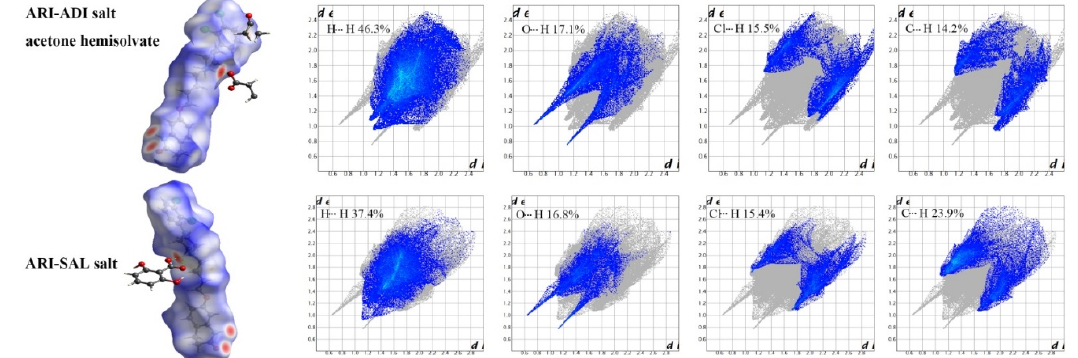
Figure 7. The 3D Hirshfeld surface and 2D fingerprint plots of two multicomponent crystals of ARI.